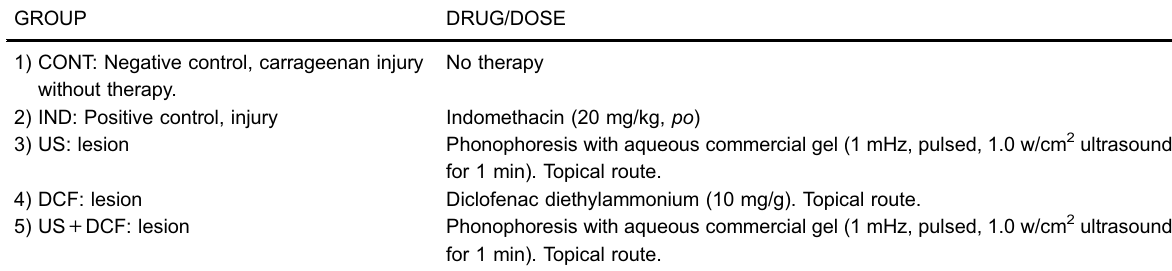
Table 1. Protocol 1 for evaluation of the anti-in fl ammatory and antinociceptive effects of phonophoresis in the paw edema test.